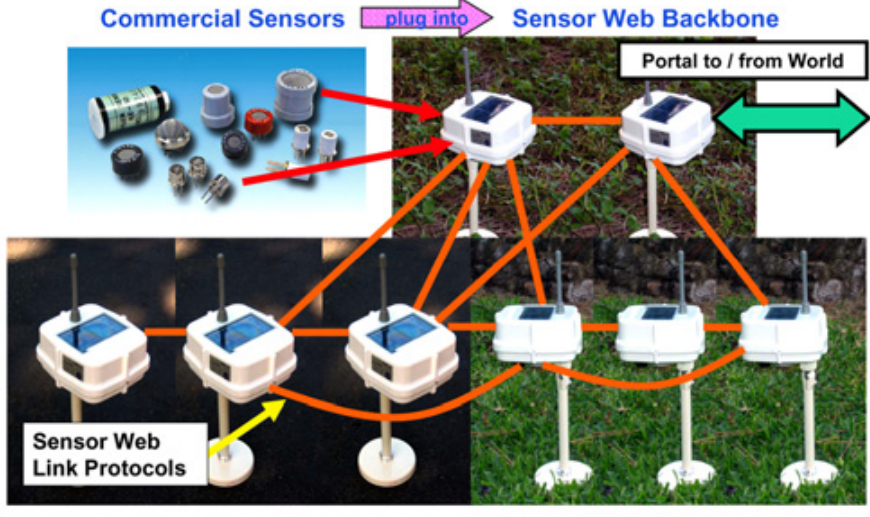
Figure 2. The Sensor Web forms an informational backbone that creates a dynamic infrastructure for the sensors in the Sensor Web